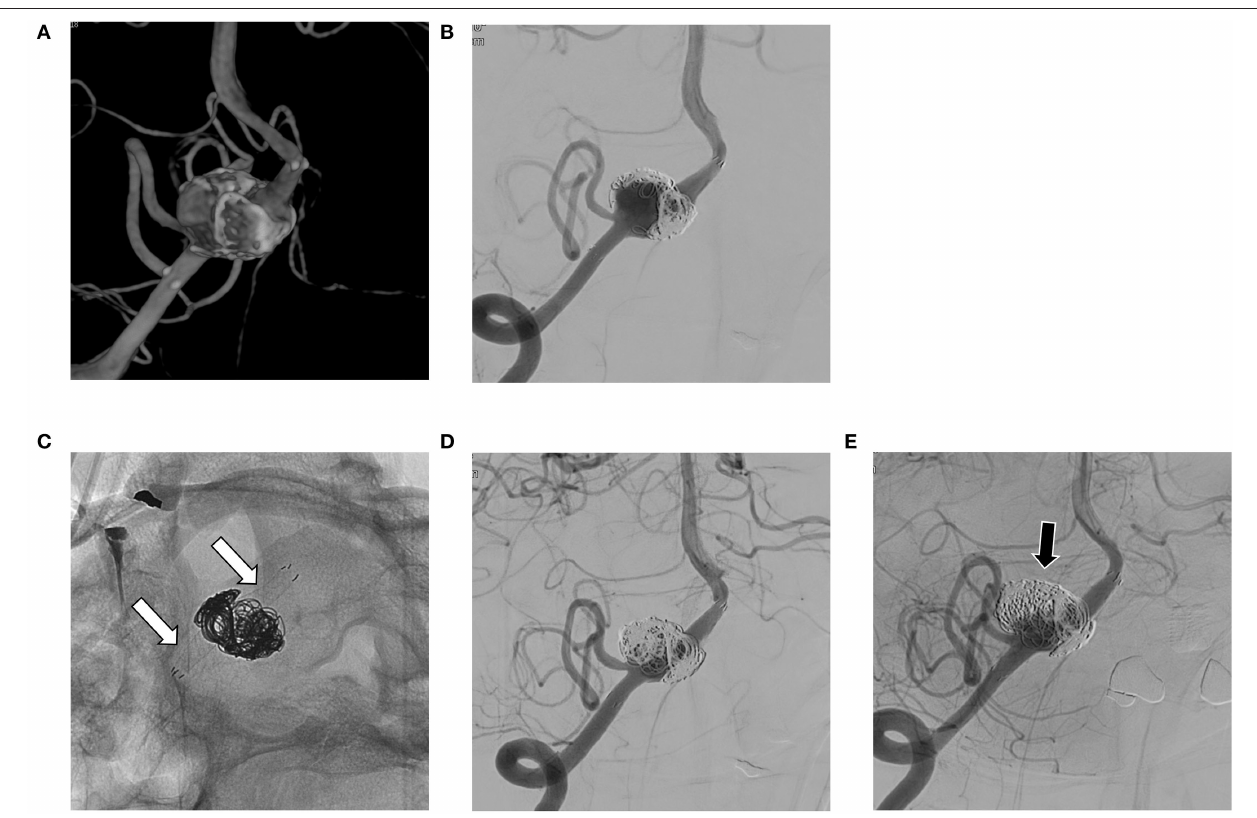
FIGURE 3 | (A,B) Recurrent aneurysm is noted at 6 months after stent-assisted coil embolization in the right vertebral artery; (C,D) A flow diverting stent is deployed over the previous stent (white arrows in C); (E) On follow-up angiography after 24 months, the residual sac remains (black